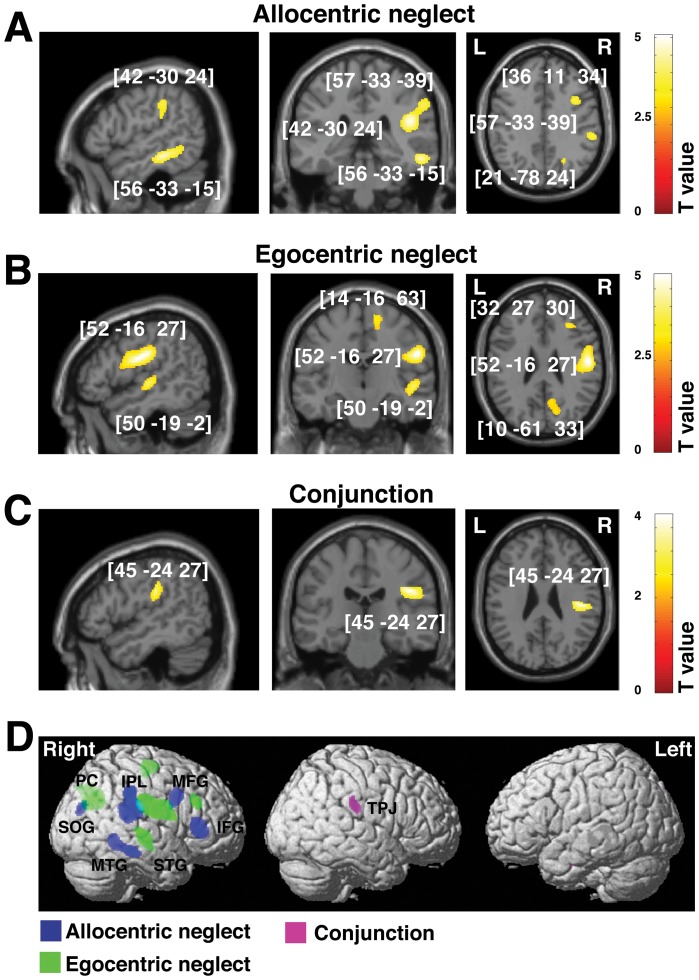
Voxel-wise statistical analysis of grey matter damage: allocentric vs. egocentric neglect at the sub-cacute phase following stroke.VBM results showing voxels corresponding to grey matter damage in (A) left allocentric, (B) left egocentric and (C) both forms of neglect (conjunction analysis). Please note that in A, B and C the lesioned areas are coloured according to their significance level in the VBM analysis, where a brighter colour means a higher t-value. The numbers in brackets indicate peak MNI coordinates. (D) To further illustrate the relationship between grey matter loss associated with allocentric and egocentric symptoms at the sub-acute phase, all clusters identified by VBM as de scribed above are plotted on a rendered brain. IFG, inferior frontal gyrus; IPL, inferior parietal lobule; MFG, frontal gyrus; MTG, middle temporal gyrus; PC, precuneus; STG, superior temporal gyrus; SOG, superior occipital gyrus; TPJ, temporal-parietal junction.